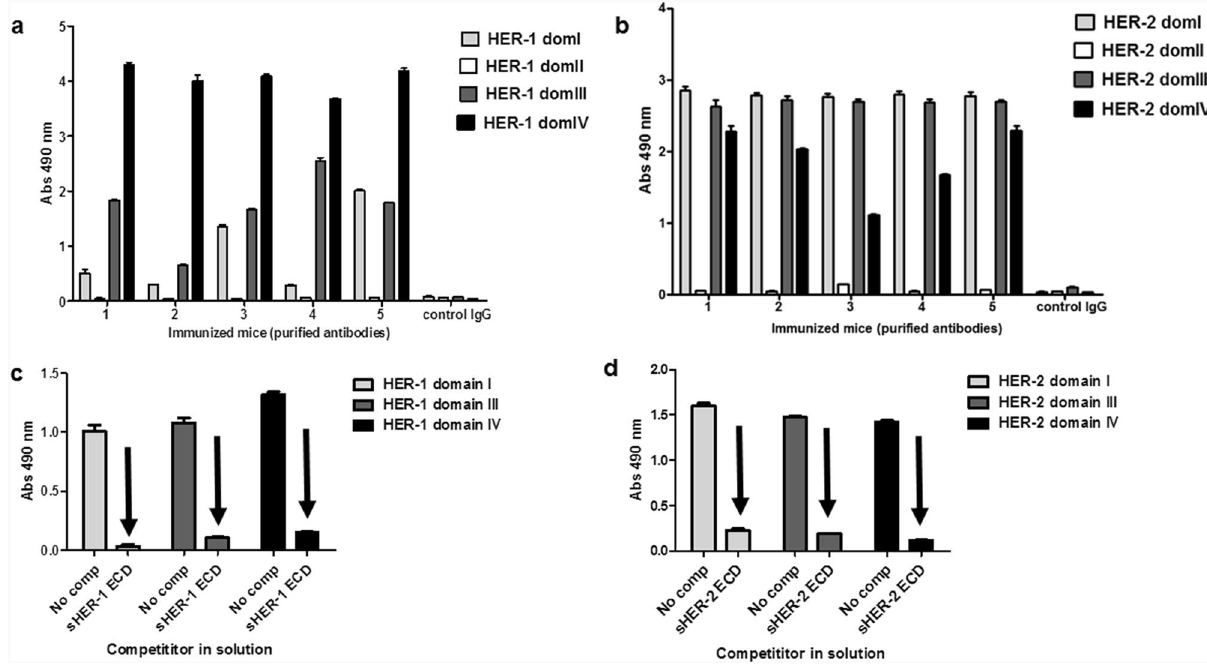
Figure 4. Domain recognition by antibodies elicited through immunization with HER-1/HER-2. Mice were immunized subcutaneously with a first dose of either HER-1 or HER-2 recombinant whole extracellular domain (ECD) emulsified in Complete Freund’s Adjuvant, followed by three additional doses in Incomplete Freund’s Adjuvant (IFA) every two weeks. Antibody-rich ascitic fluid was collected after intraperitoneal priming with IFA and myeloma inoculation, and IgG antibodies were purified by Protein A affinity chromatography. Reactivity against phage-displayed HER1 ( a ) and HER2 ( b ) domains was tested by ELISA on polyvinyl chloride microtiter plates coated with purified antibodies from each immunized mouse. Bound phage-displayed HER domains were detected with an anti-M13 mAb conjugated to horseradish peroxidase. Immunoglobulins from non-immunized mice were used as negative control. The specificity of recognition was assessed by competition ELISA. Phage- displayed individual domains of either HER-1 ( c ) or HER-2 ( d ) were either mixed with the whole recombinant ECD in solution (sECD) of the corresponding antigen or diluted without any competitor (No comp), and then added to microtiter plates coated with the pool of purified antibodies from immunized mice. Bound phage- displayed HER domains were detected with an anti-M13 mAb conjugated to horseradish peroxidase. Arrows indicate specific inhibition of recognition of phage-displayed HER domains by the competitor soluble ECD of each